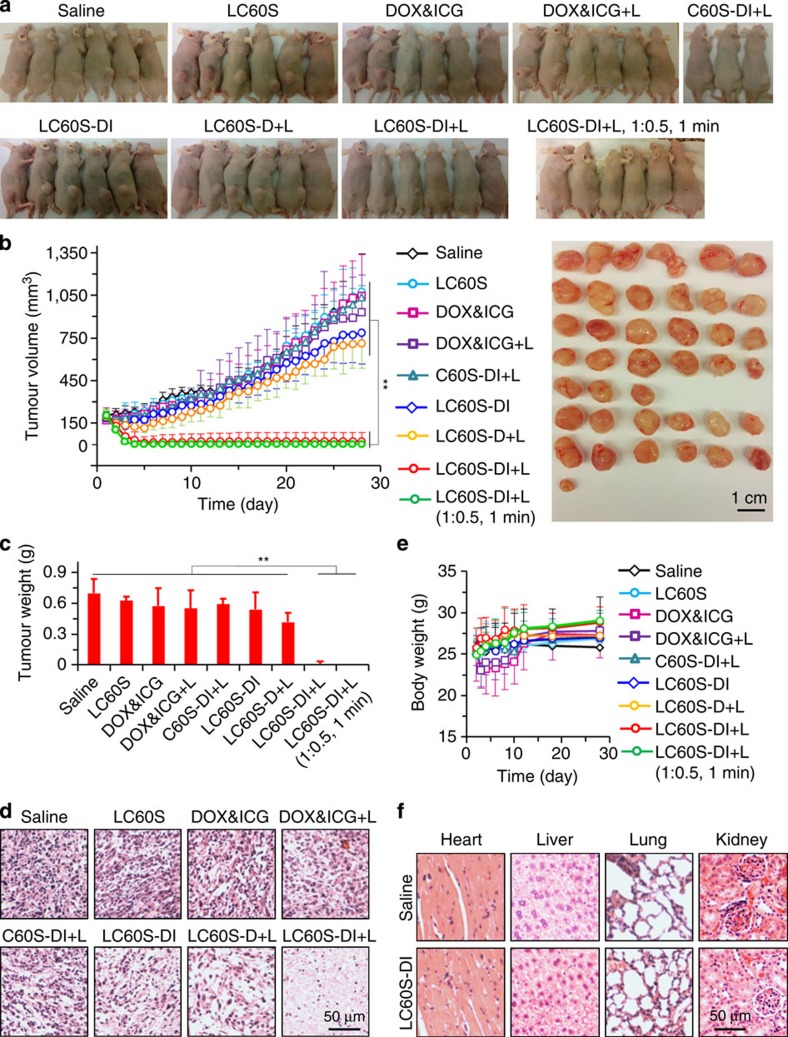
Augmented safety and efficacy of cancer destruction in vivo.(a) Photographs of mice on day 28 after nine different treatments. (b) Growth curves of tumours in the mice together with images of the tumours collected on day 28 after killing the mice. Error bars represent±s.d. (n=3 for C60S-DI+L group, n=6 for other groups). **P<0.01. (Kruskal–Wallis H test). (c) Weight of the tumours collected after killing the mice on day 28. Error bars represent±s.d. (n=3 for C60S-DI+L group, n=6 for other groups). **P<0.01. (Kruskal–Wallis H test). (d) Representative images of histology (H&E) of the tumours collected on day 28. (e) Body weight of the mice with the various treatments showing no significant difference between them. (f) Histological (H&E) images of major organs collected on day 28 showing no evident systemic toxicity of the LC60S nanoparticles. The unspecified ratios of DOX to empty nanoparticle and DOX to ICG for making the DOX- and/or ICG-laden nanoparticles were 1:20 and 1:1, respectively. All non-specified NIR laser (L) irradiation was for 3 min at 0.7 W cm−2. The NIR irradiation was conducted at 12 h after intravenous administration of the various drug formulations.